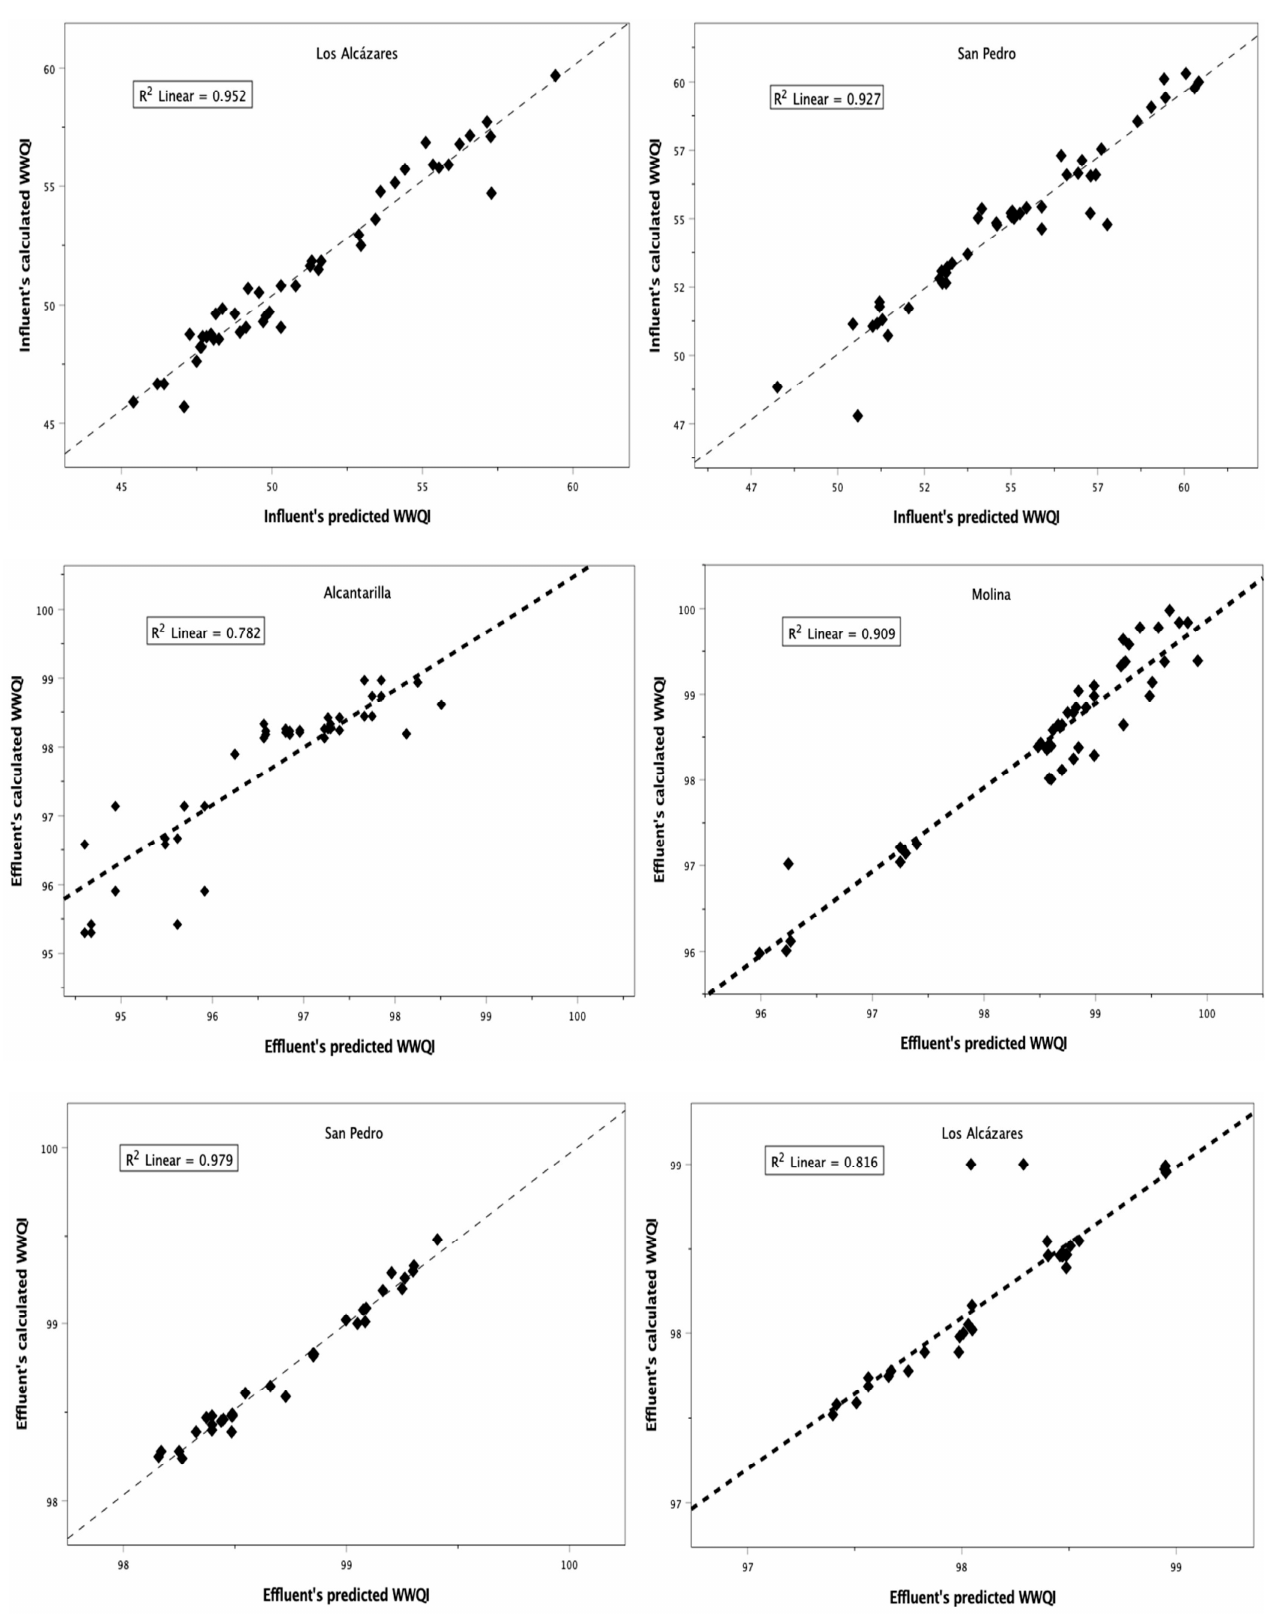
Figure 4. Scatter plots of calculated and predicted values of WWQI.